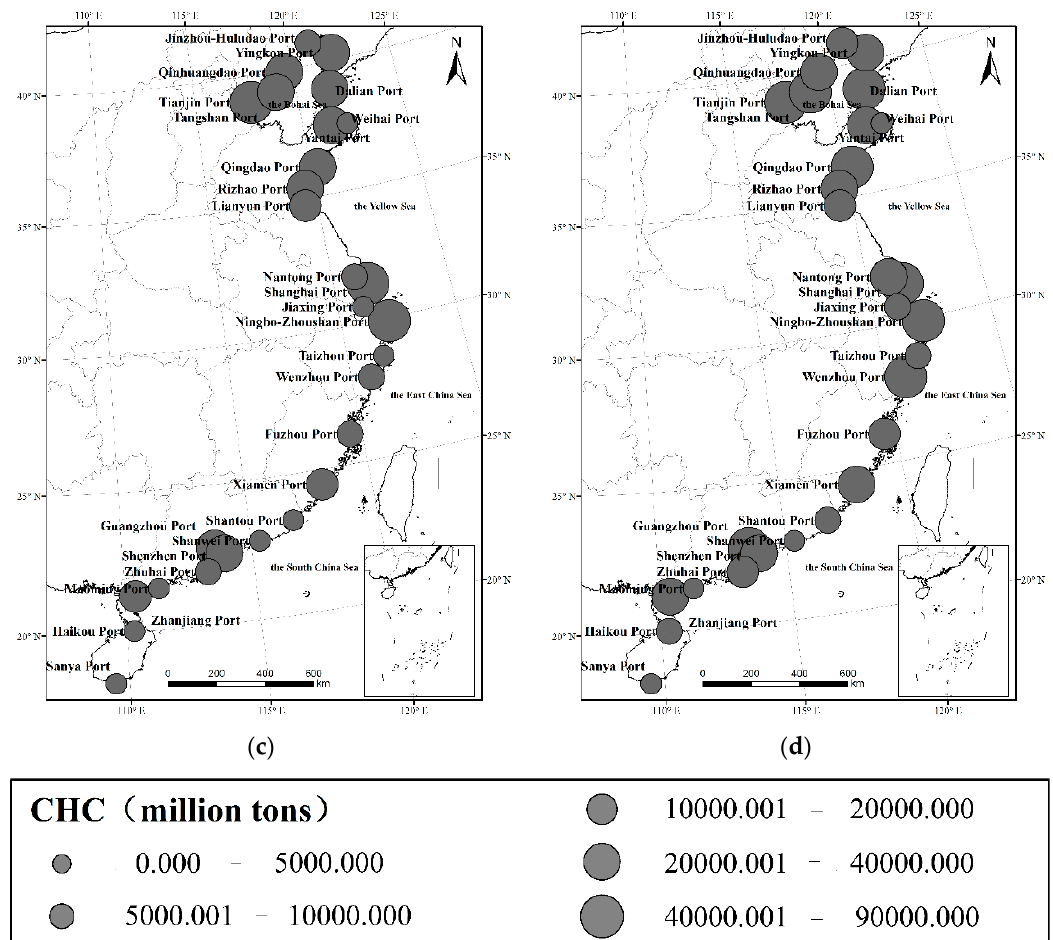
Figure 10. Spatiotemporal analysis of CHC for coastal ports in China: ( a ) spatiotemporal analysis of 2001 CHC for coastal ports in China; ( b ) spatiotemporal analysis of 2005 CHC for coastal ports in China; ( c ) spatiotemporal analysis of 2010 CHC for coastal ports in China; ( d ) spatiotemporal analysis of 2015 CHC for coastal ports in China.